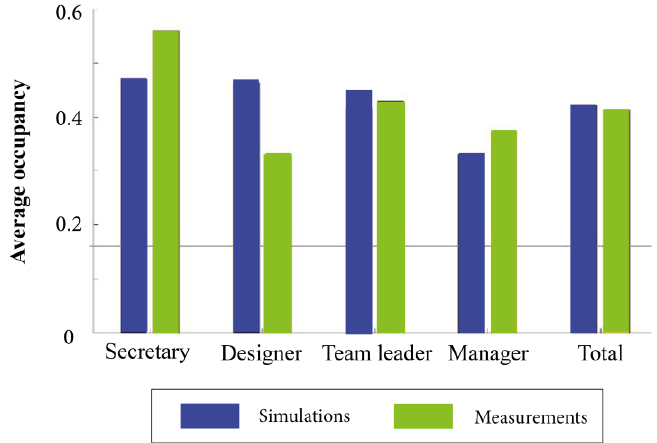
Figure 5. Average simulated and measured occupancy for the four job-function types and the entire office space.